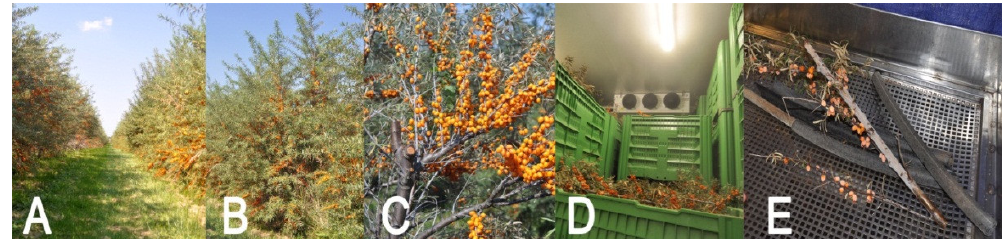
Figure 1. ( A ) Commercial sea buckthorn planting at PD Tvrdošovce; ( B , C ) mature bushes right before harvest; ( D ) industrial deep-freezer with harvested branches in big-boxes; ( E ) tools for separating berries from branches.